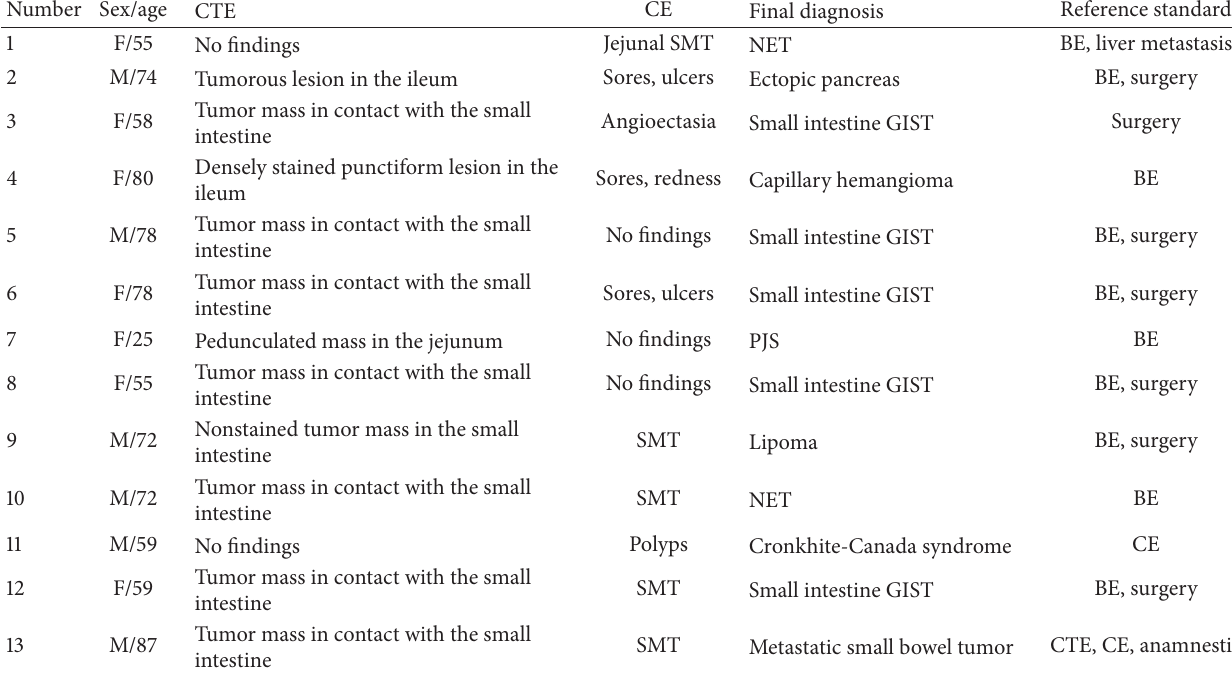
Table 3: Comparison of the computed tomography enteroclysis/enterography (CTE) and capsule endoscopy (CE) in terms of the final